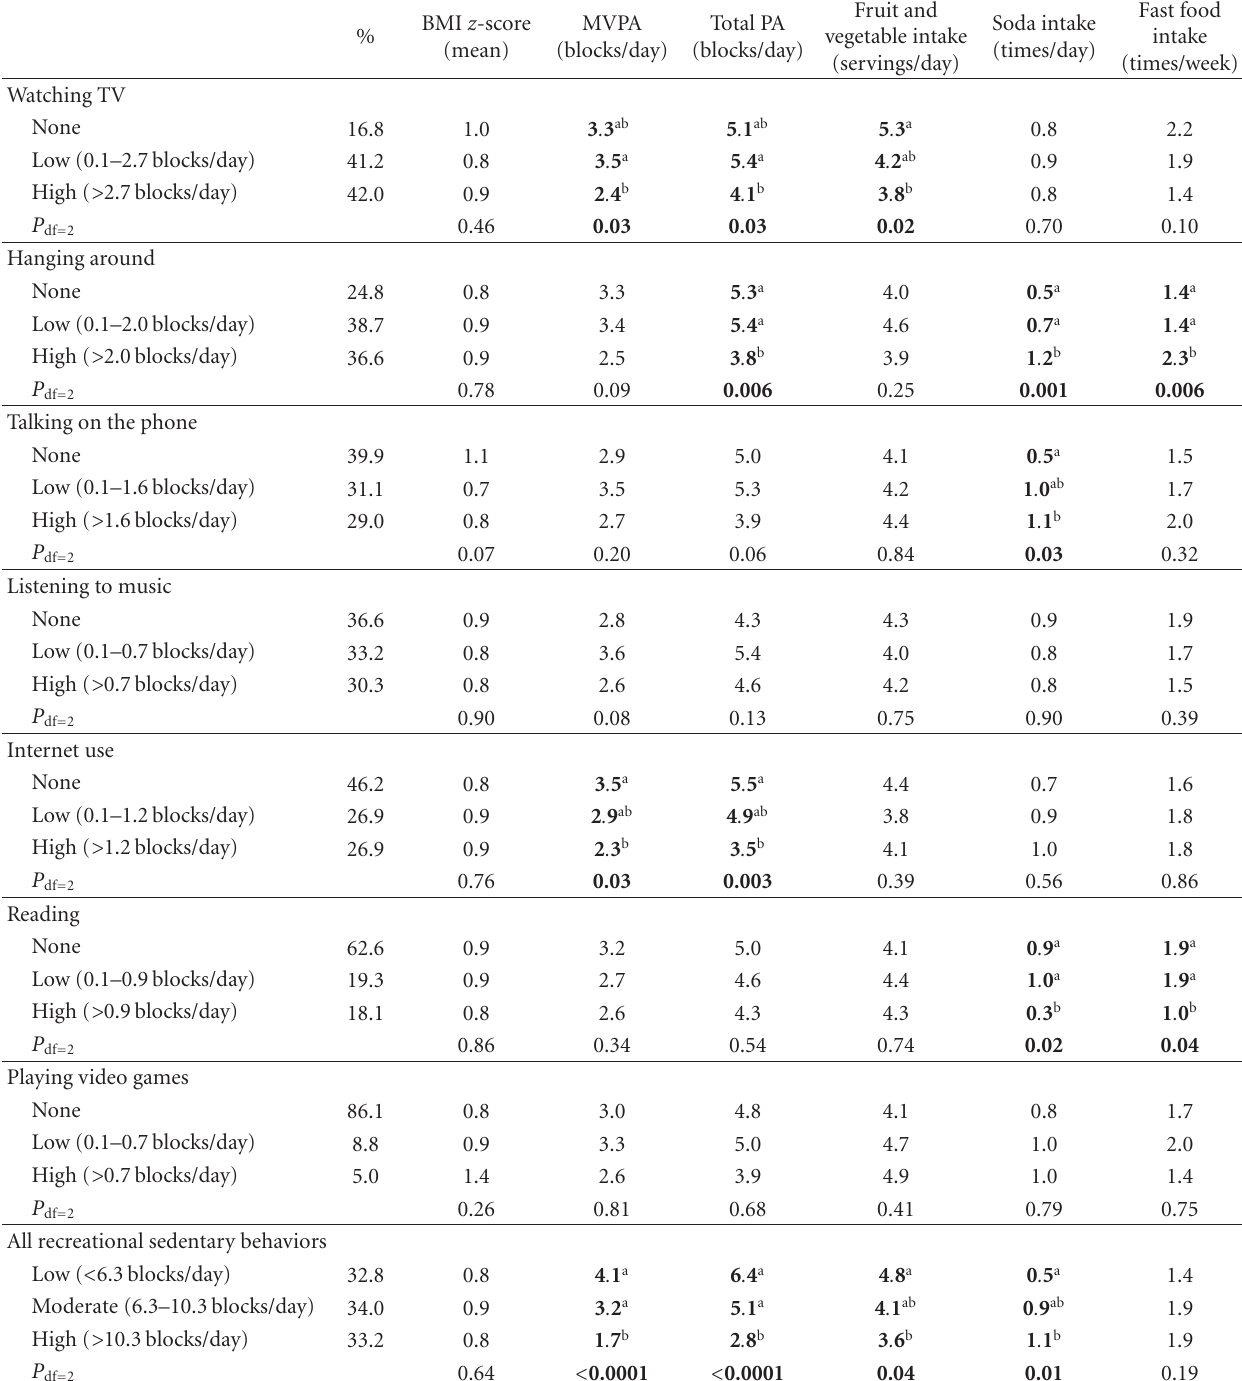
Table 2: Associations between recreational sedentary behaviors and BMI, physical activity, and dietary